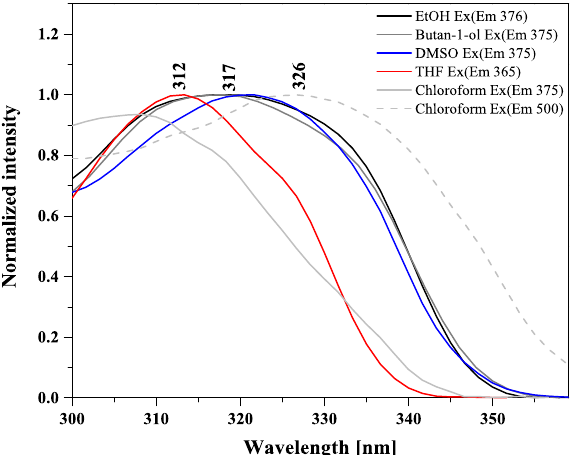
Figure 6. Normalized excitation spectra measured for NTBD in various